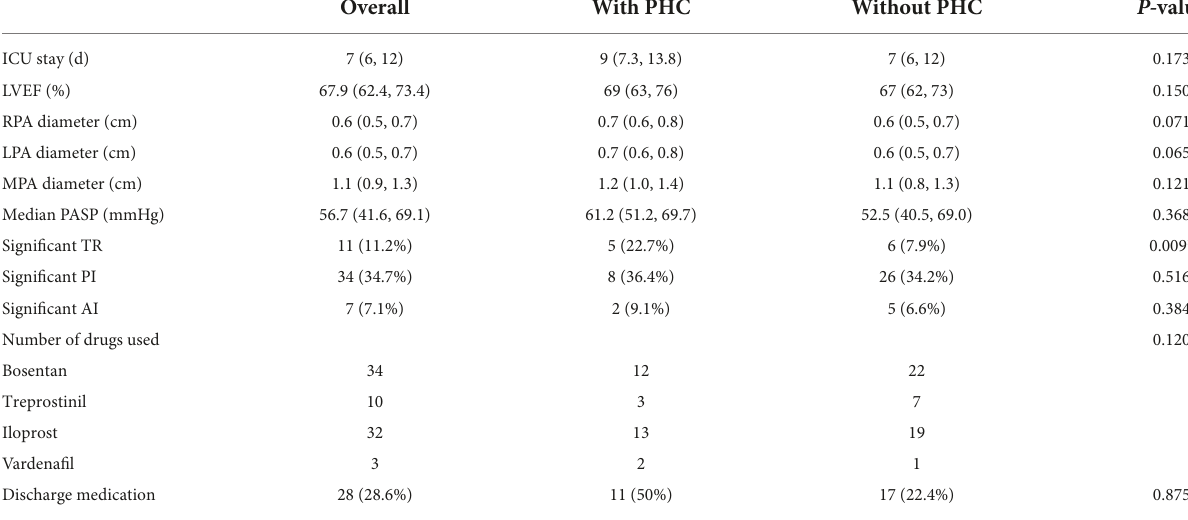
TABLE 3 Early outcomes.